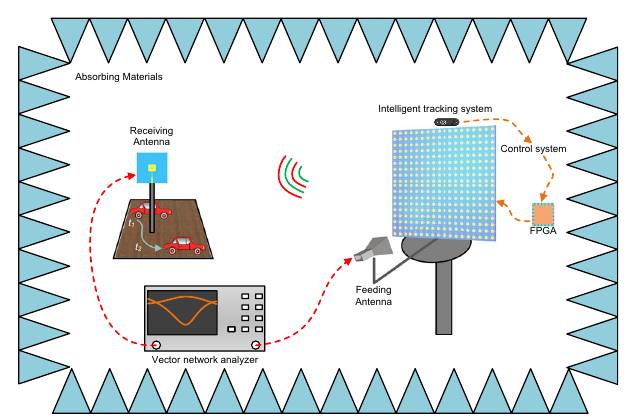
Fig. 5 | Experimental setup and environment. A TE-polarized beam from a feeding horn antenna is incident on the metasurface. The position of the moving carisprocessed inthe controlsystem, and allbiasvoltages areinstantlycalculated and supplied to the metasurface. The re fl ected waves of the metasurface are detected in real-time by the receiving antenna.